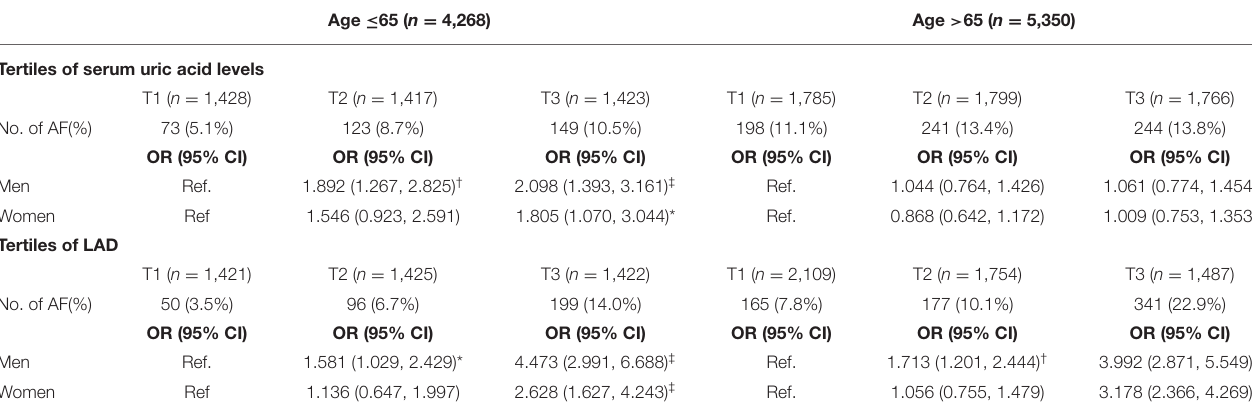
TABLE 3 | The prevalence of AF and the risk estimate for the atrial fibrillation based on the tertiles of